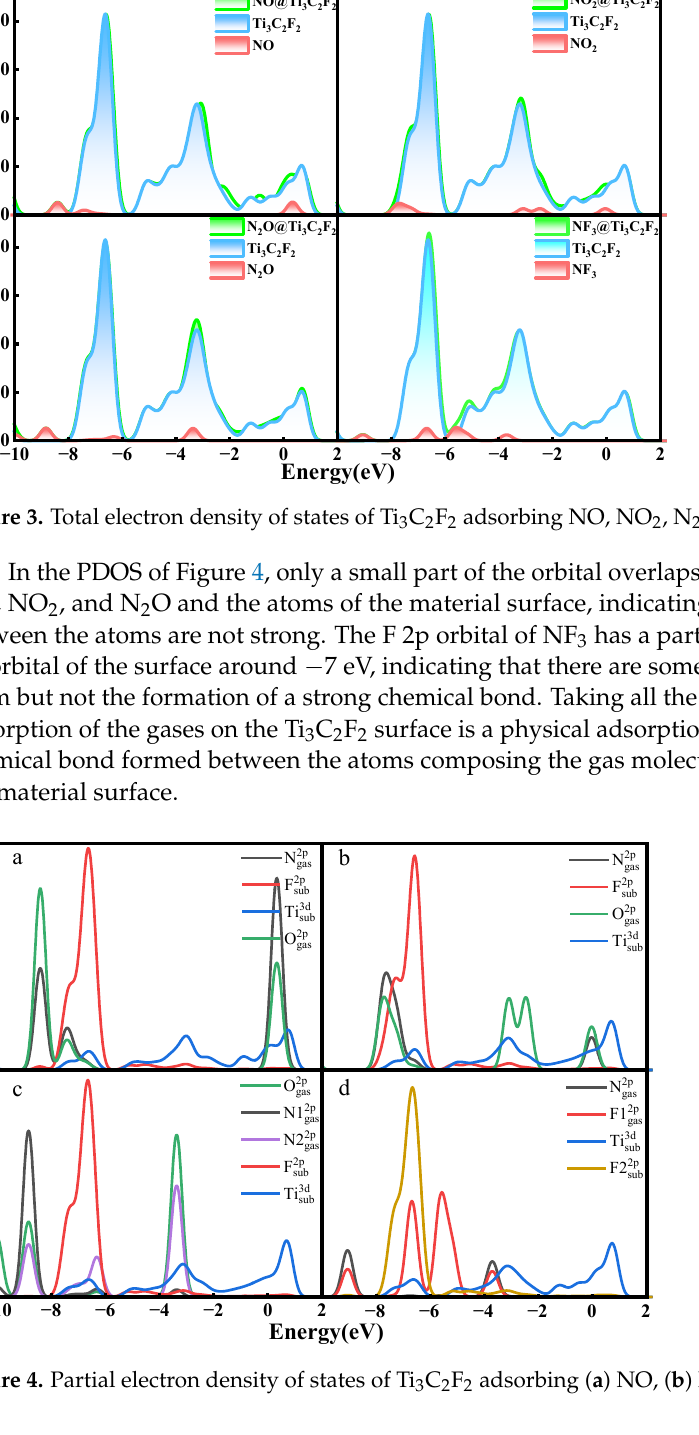
density of states of the whole system after the adsorption of NO and NO 2 experiences a significant increase near the Fermi energy level, indicating that the adsorption of these two gases enhances the conductivity of the material. This phenomenon does not occur after the adsorption of N 2 O and NF 3 . As seen from the figure, the effects of N 2 O and NF 3 on the whole adsorption system are below − 3 eV, and the density of states of the whole system does not change greatly after adsorption. So, the adsorption of these two gases does not significantly enhance the conductivity of the material. These findings are consistent with the value of the charge transfer reflected in Table 2.